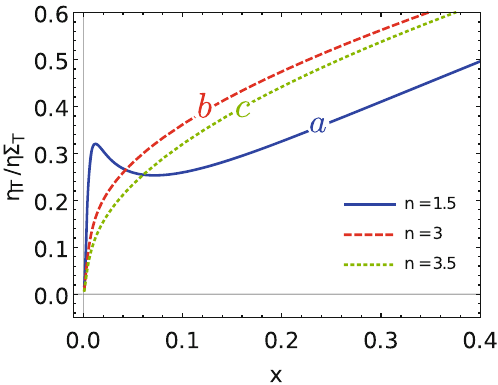
as function of x T Fig. 8 Normalized Tolman–Whittaker Mass η T /η Σ for α = 0 . 1 and different values of n . (Blue) n = 11 . 5. (Red) n = 3. (Green) n = 3 . 5. Values of y are read off Fig.